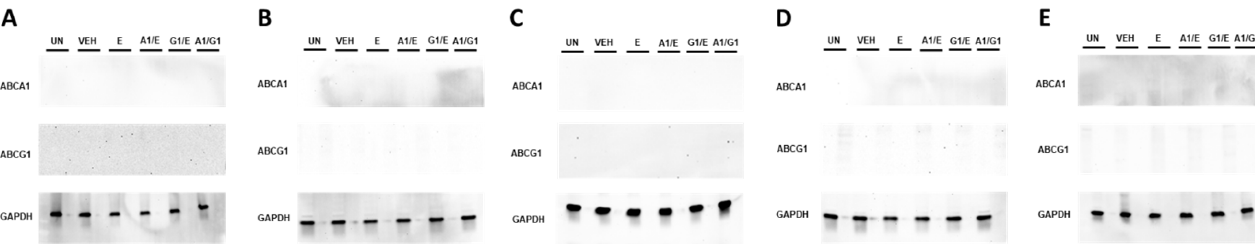
Figure 1. ABC-transporter protein expression is absent in HEK293 cells transfected with ABCA1-LSL and ABCG1-LSL-based plasmids. ( A – E ) Cultured HEK293 cells were either untreated (UN), vehicle-treated (VEH), transfected with empty vector plasmid ( E ), transfected with ABCA1-LSL plasmid and empty vector plasmid (A1/E), transfected with ABCG1-LSL plasmid and empty vector plasmid (G1/E), or transfected with ABCA1-LSL and ABCG1-LSL plasmids (A1/G1). Post-treatments, cell lysates were harvested 24 h ( A ), 36 h ( B ), 48 h ( C ), 60 h ( D ), or 72 h ( E ) after the respective treatments. ( A – E ) Western blotting was used for attempted detection of ABCA1 and ABCG1 proteins in cell lysates, with GAPDH used as a loading control.